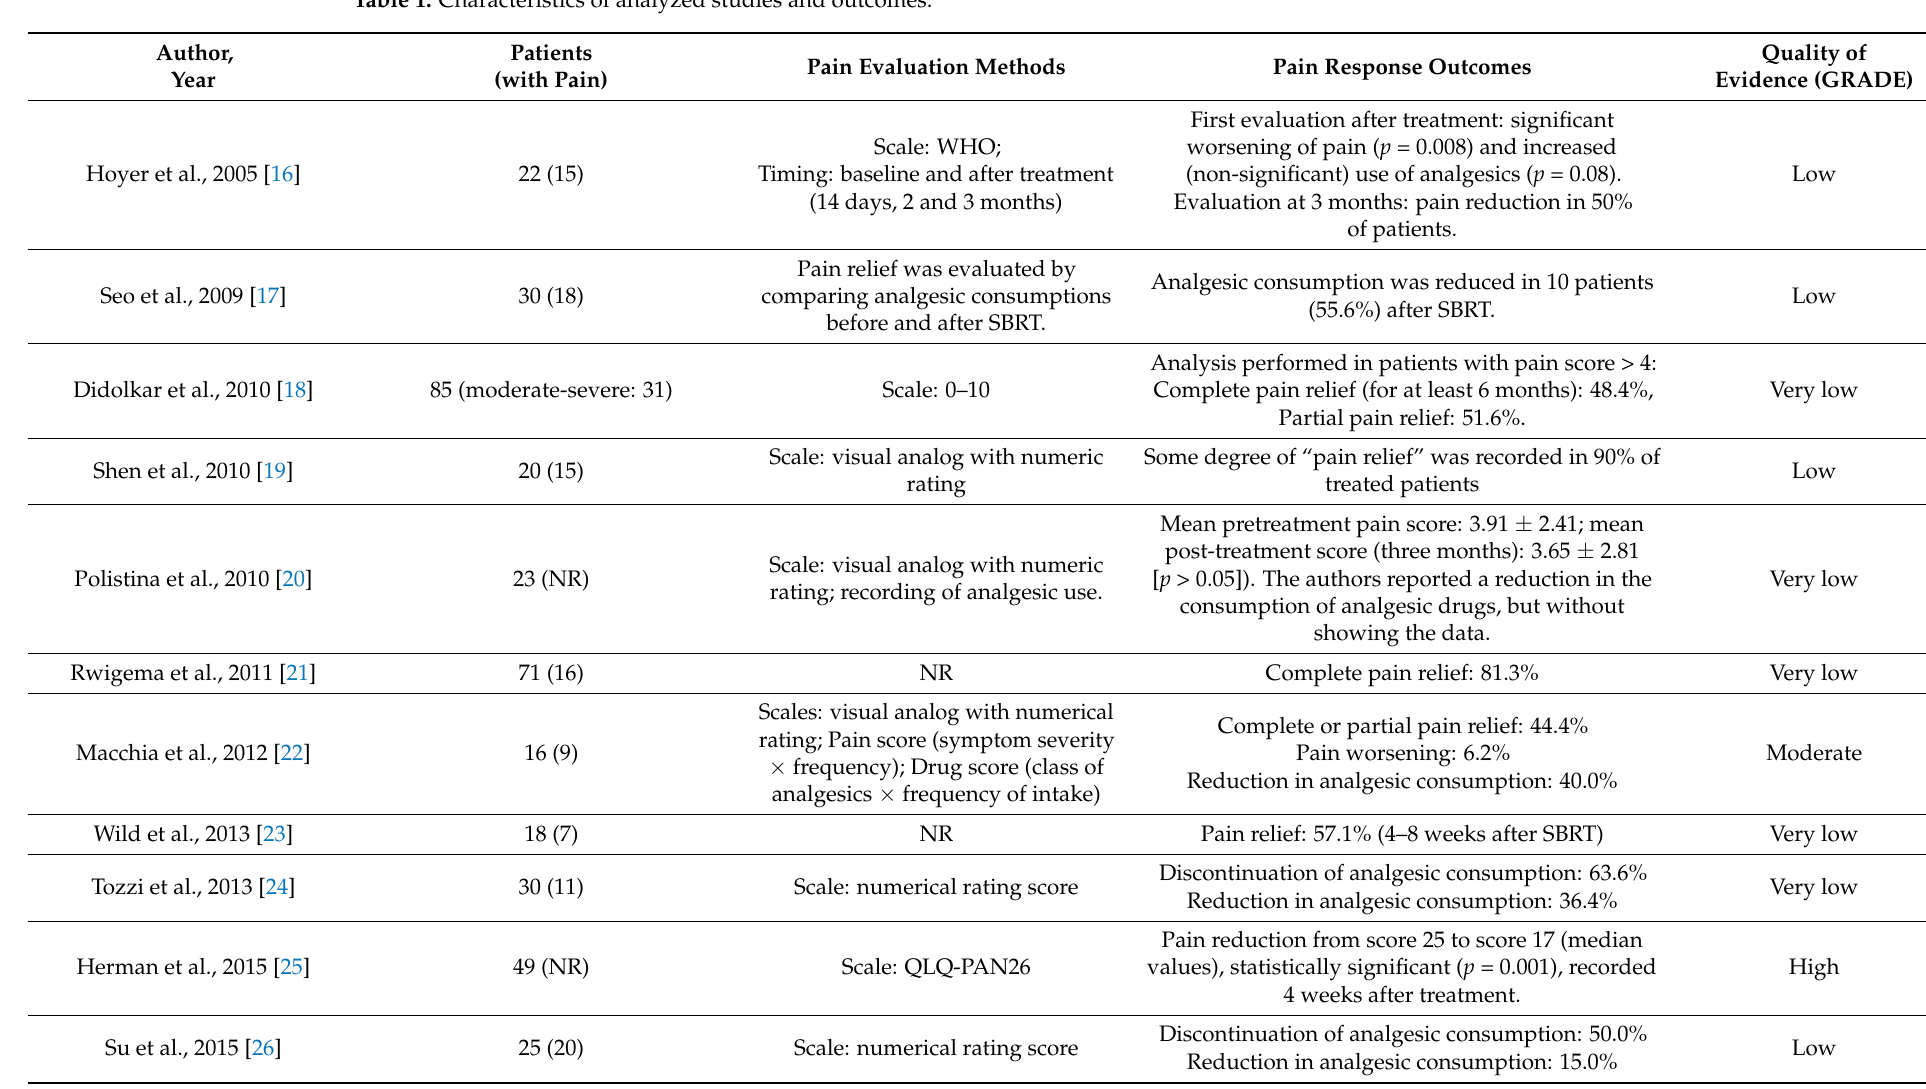
Table 1. Characteristics of analyzed studies and